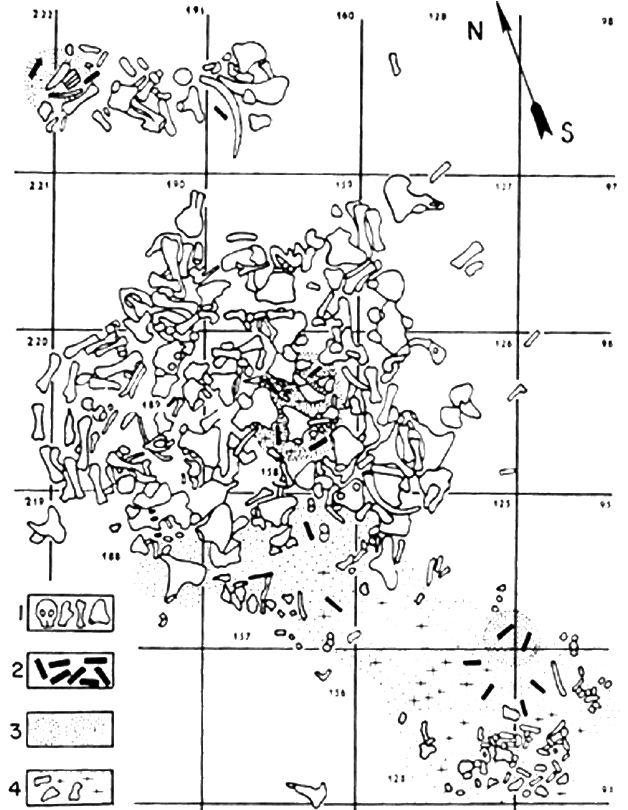
Figure 5. Mezhyrich Dwelling 2 [30]. Photo: courtesy Olga